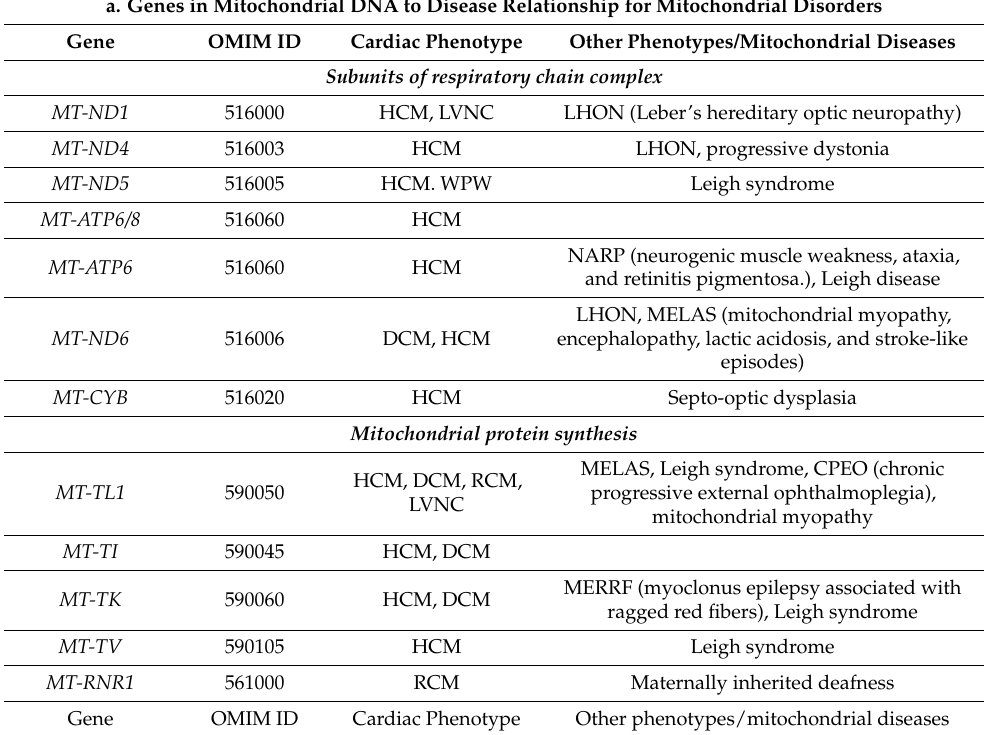
Table 1. Causative genes for mitochondrial cardiomyopathy